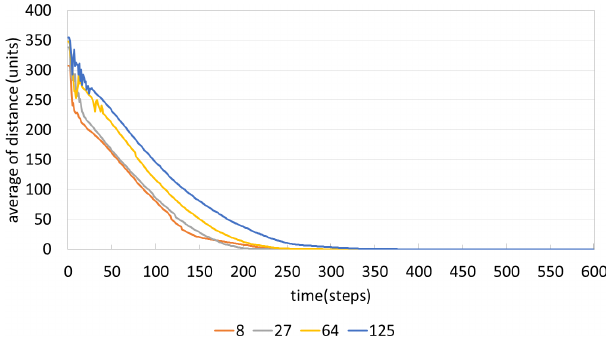
Fig. 22. Average of distances to the target positions in the formations with di®erent numbers of robots: The cases of 8, 27, 64 and 125